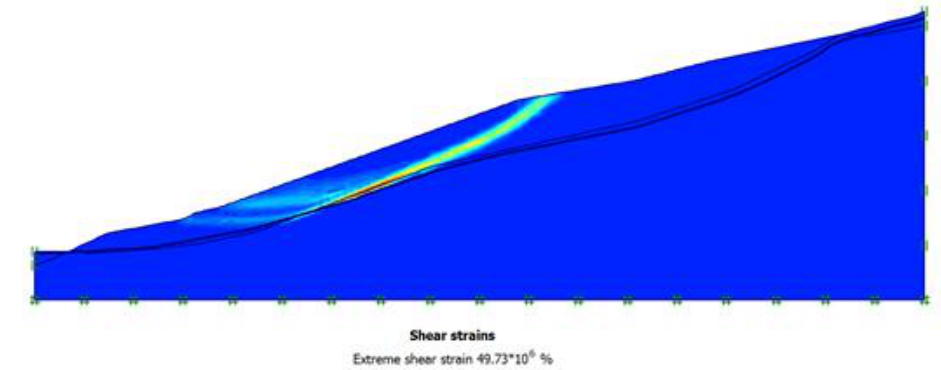
Fig. 7. Failure wedge display, after analysis by Phi-C reduction method.